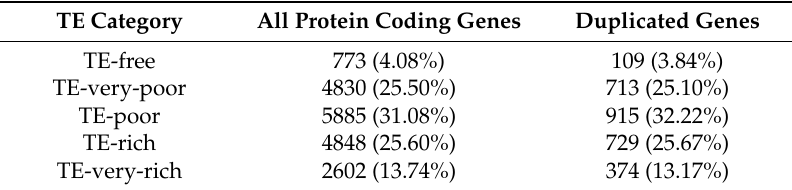
Table 1. Number of genes according to their TE neighborhood category.